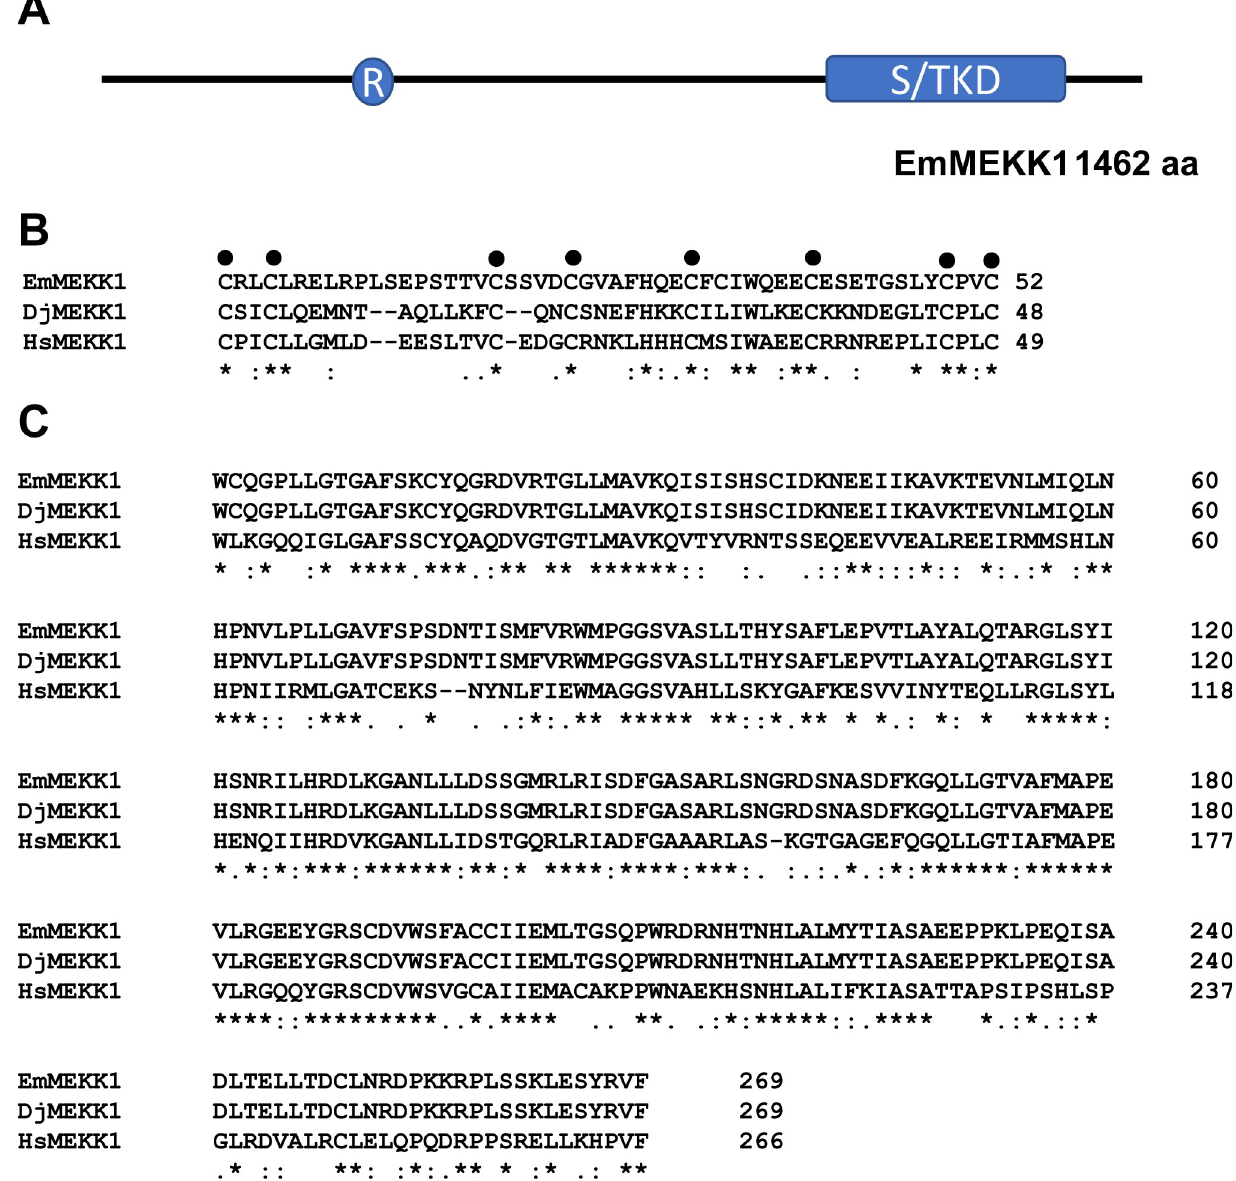
Fig 1. Sequence features of EmMEKK1. (A) EmMEKK1 domain structure. Shown in blue are the locations of the RING domain (R) and the serine/ threonine kinase domain (S/TKD). (B) Amino acid sequence alignment of the RING domains of different MEKK1 orthologs of E . multilocularis (EmMEKK1; this work), Dugesia japonica (DjMEKK1; DDBJ/EMBL/GenBank accession no.: BBA10910) and H . sapiens (HsMEKK1; Q13233). Sites of perfect alignment ( � ) as well as groups of strong (;) or weak (.) similarity are marked below the alignment. Highly conserved cysteine residues of the RING zink-finger are additionally marked by a dot above the alignment. (C) Amino acid sequence alignment of serine/threonine kinase domains of different MEKK1 orthologs. Sequence origins and decorations are as in (B).